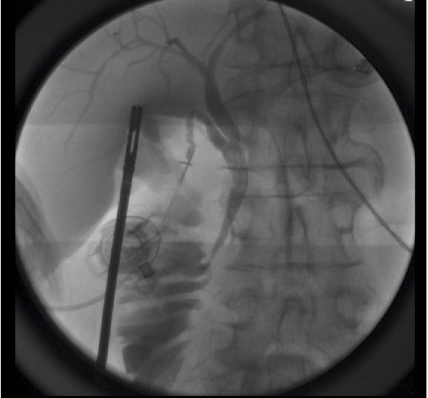
Figure 6: Intraoperative cholangiogram revealed single channel entering common bile